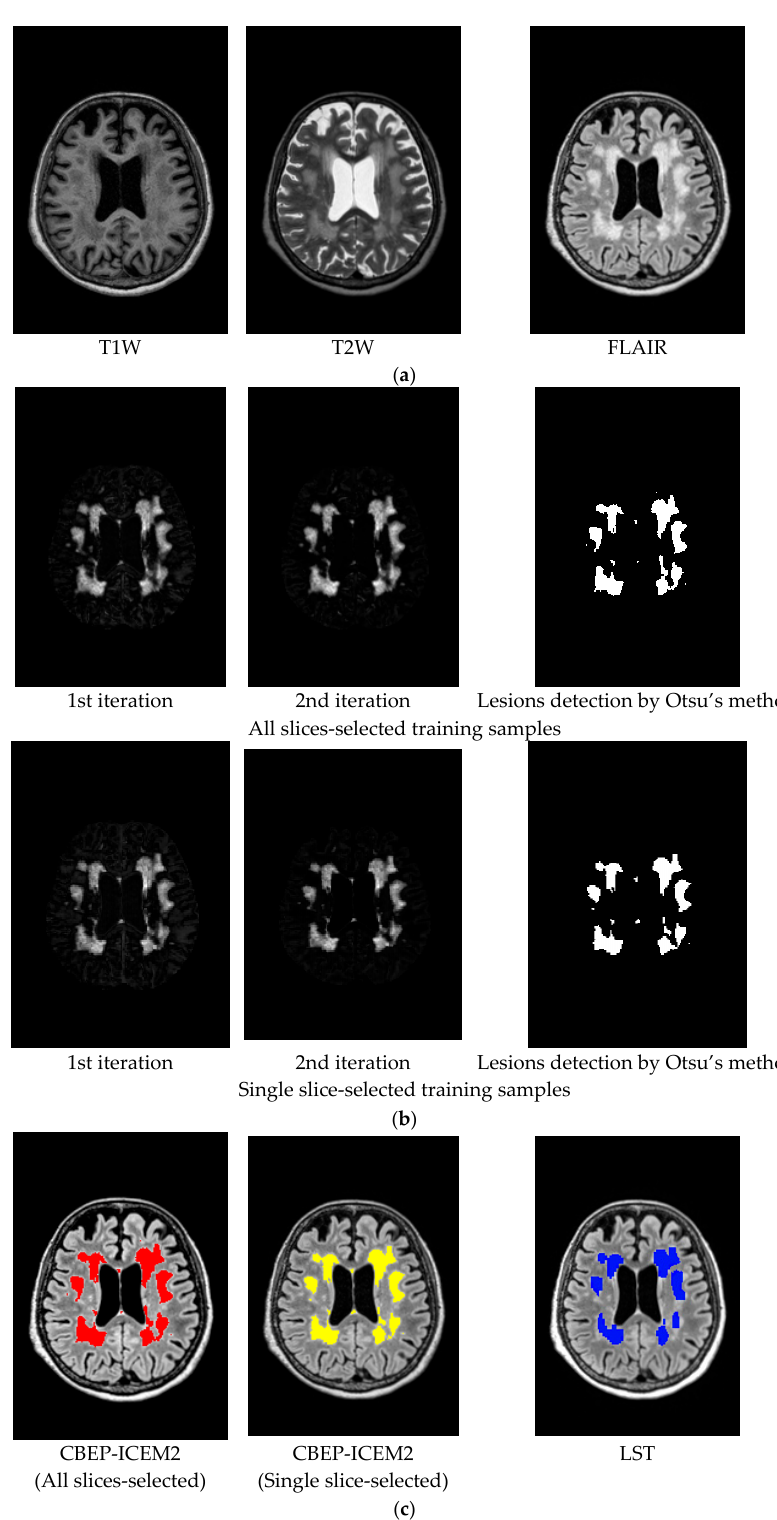
Figure 14. Lesion detection of Fazekas grade 3 By CBEP-ICEM2 and LST. ( a ) Original MR images (T1W, T2W, FLAIR) with lesions of Fazekas grade 3; ( b ) Lesion detection by CBEP-ICEM2; ( c ) Comparison between lesion detections by CBEP-ICEM2 and LST.